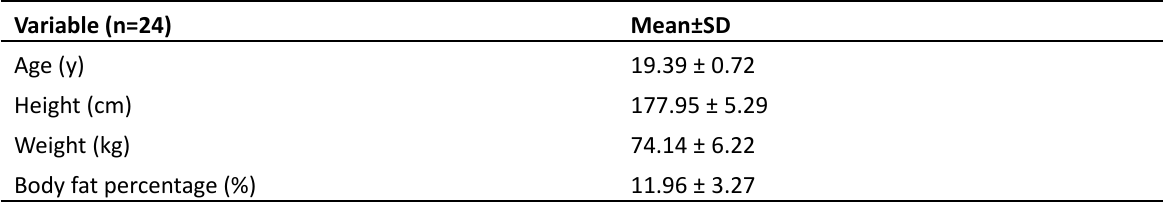
Table 1. Anthropometric profile of kick boxers Variable